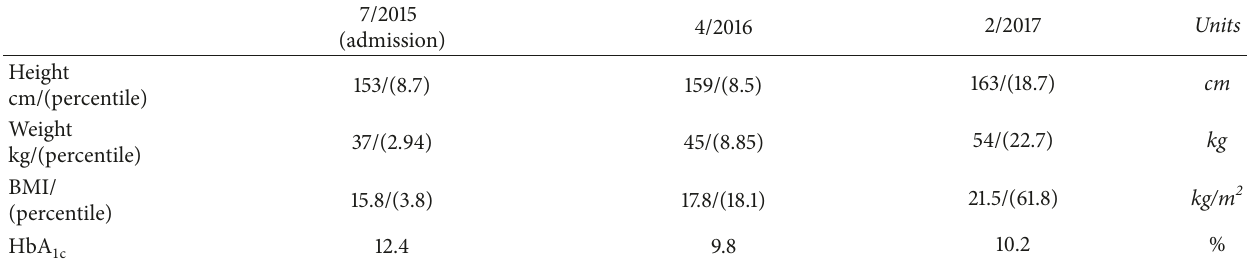
Table 4: Height, weight, HbA 1 c , and BMI on follow-up